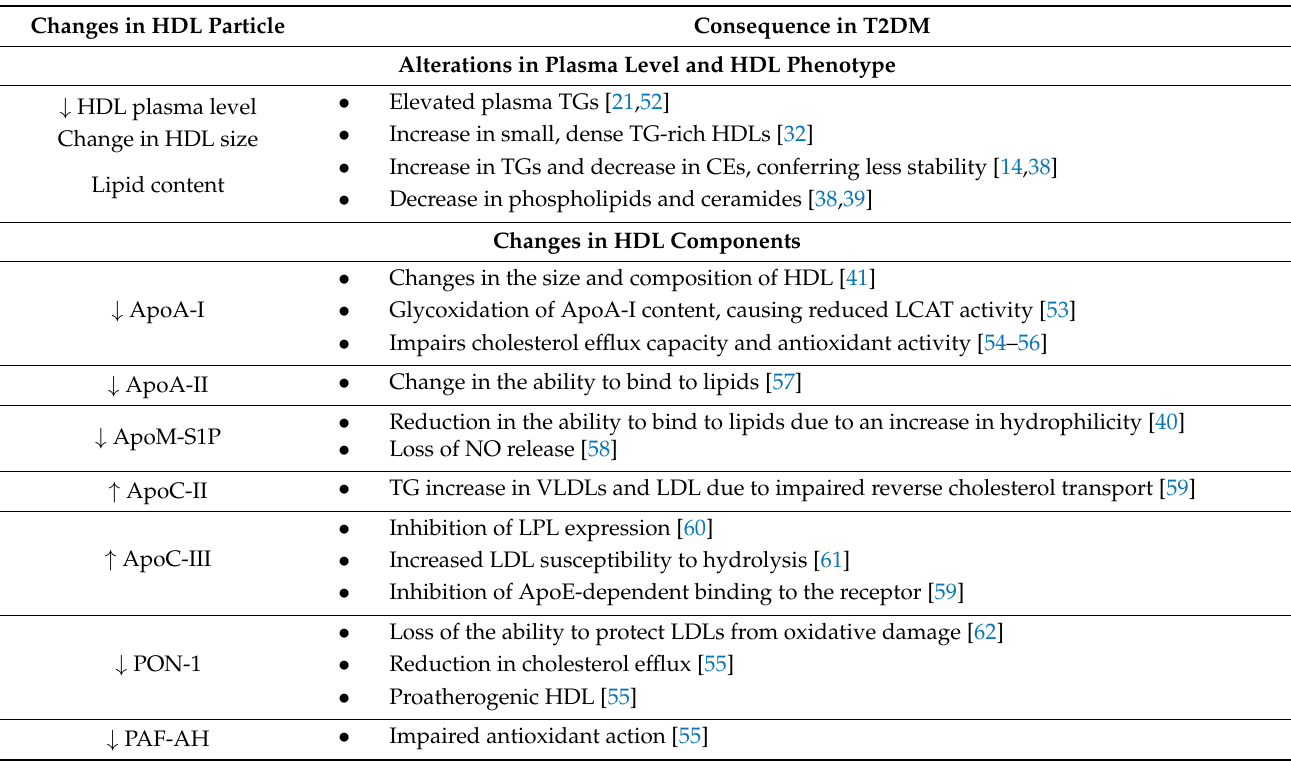
Table 1. Summary of HDL’s structural and functional changes in patients with type 2 diabetes mellitus. Changes in HDL Particle Consequence in T2DM Alterations in Plasma Level and HDL